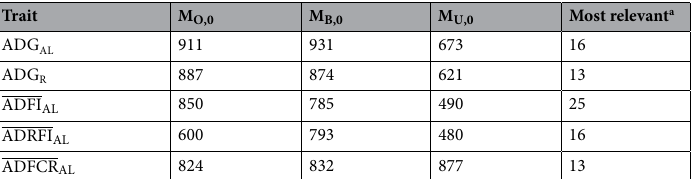
Table 8. Number of OTUs selected in at least 80 out of the 100 sPLSR replicates conducted for microbial effects predicted with covariance matrices M O , 0 , M B , 0 and M U , 0 for growth and FE traits. ADG AL , average daily gain in rabbits fed ad libitum; ADG R , average daily gain in rabbits fed under restriction; ADFI AL , average daily feed intake in rabbits fed ad libitum; ADRFI AL , average daily residual feed intake in rabbits fed ad libitum; ADFCR AL , average daily feed conversion ratio in rabbits fed ad libitum; M O , 0 , microbial relationship covariance matrix defined from CSS normalized OTU counts and expanded by including ones in the diagonal and zeros outside the diagonal for the animals without microbial information, M B , 0 , microbial relationship covariance matrix defined from Bray–Curtis distance matrix and expanded by including ones in the diagonal and zeros outside the diagonal for the animals without microbial information; M U , 0 , microbial relationship covariance matrix defined from weighted Unifrac distance matrix and expanded by including ones in the diagonal and zeros outside the diagonal for the animals without microbial information. a The most relevant OTUs were those with the greatest loading weights and that were selected with M O , 0 , M B , 0 and M U , 0 .